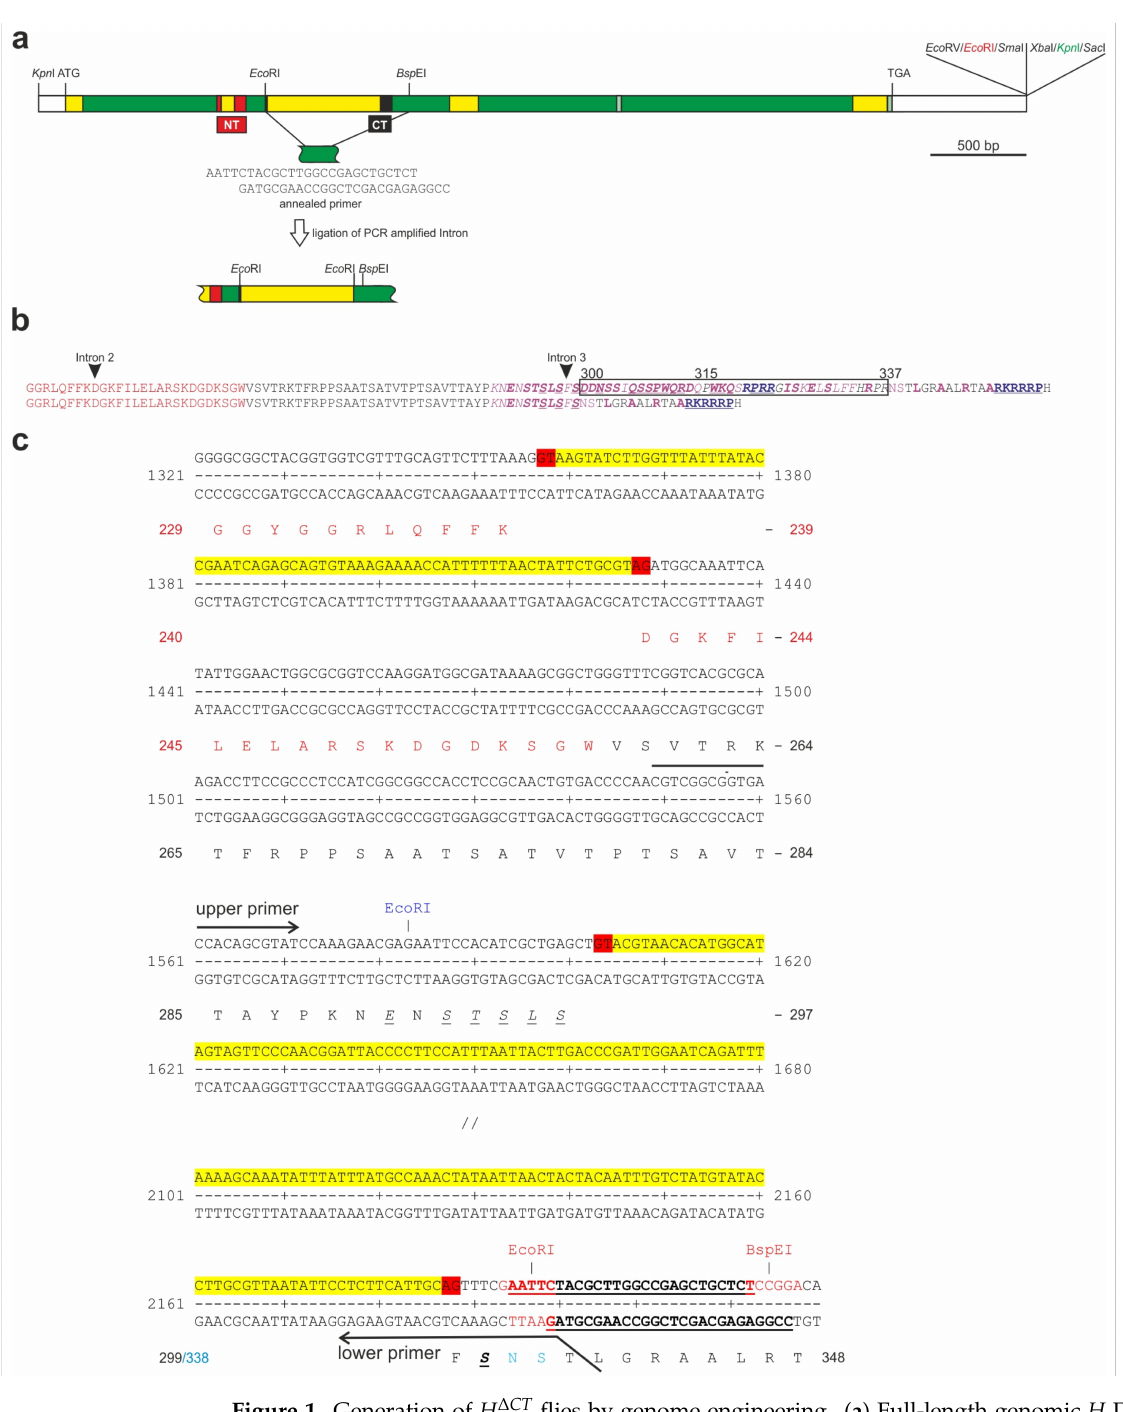
Figure 1. Generation of H ∆ CT flies by genome engineering. ( a ) Full-length genomic H DNA was cloned into pBT between Kpn I and Eco RV polylinker sites [17]. Coding sequences are shown in